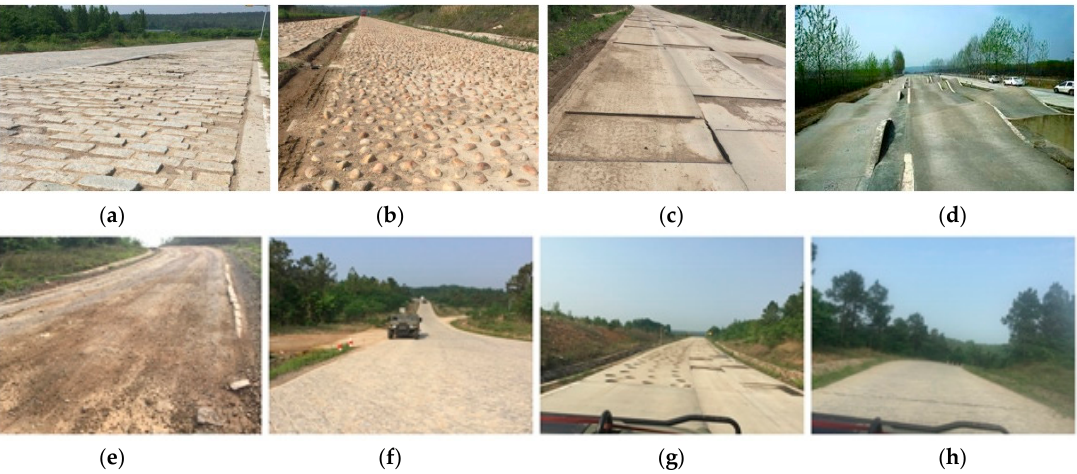
Figure 1. The special roads: ( a ) Belgium road; ( b ) Cobblestone road; ( c ) Square pit road; ( d ) Twisted road; ( e ) Muddy road; ( f ) Gravel road; ( g ) Round pit road; ( h ) Stone road.